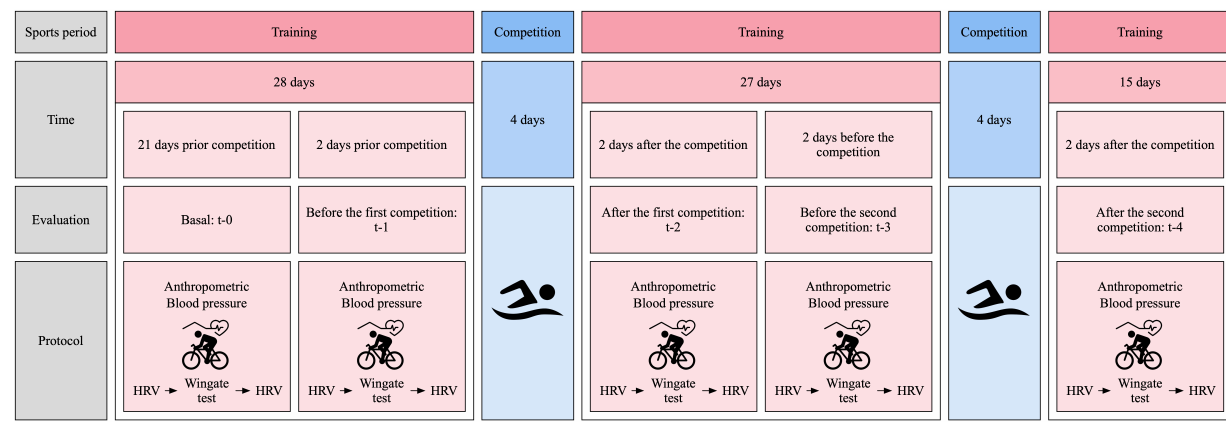
Frontiers in Physiology |